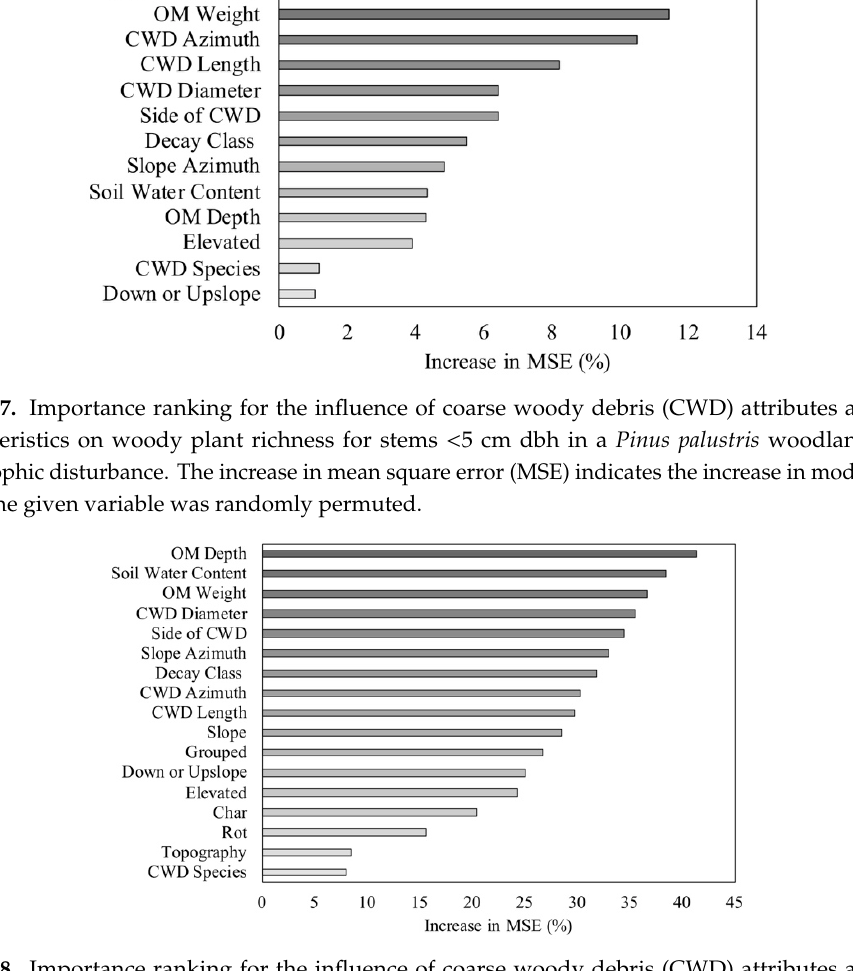
Figure 8. Importance ranking for the influence of coarse woody debris (CWD) attributes and site characteristics on woody plant height for stems <5 cm dbh in a Pinus palustris woodland after catastrophic disturbance. The increase in mean square error (MSE) indicates the increase in model error when the given variable was randomly permuted.